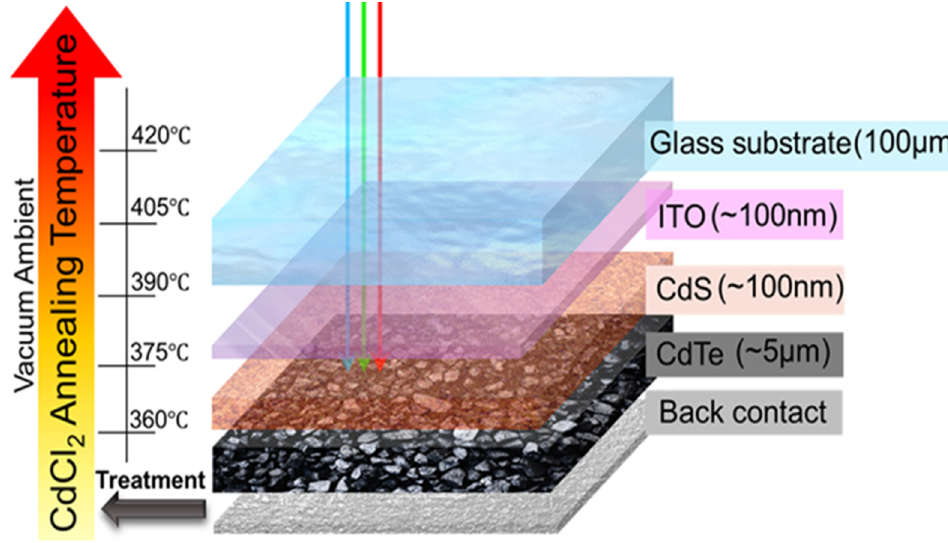
Figure 1. Schematic view of CdTe solar cell structure with a post-annealing temperature range. In general, CdCl 2 improves the short circuit current and open circuit voltage through enhancing the crystallite grain nucleation in CdTe, recrystallization, surface amendment, grain boundaries passivation, doping concentration modification, assisting